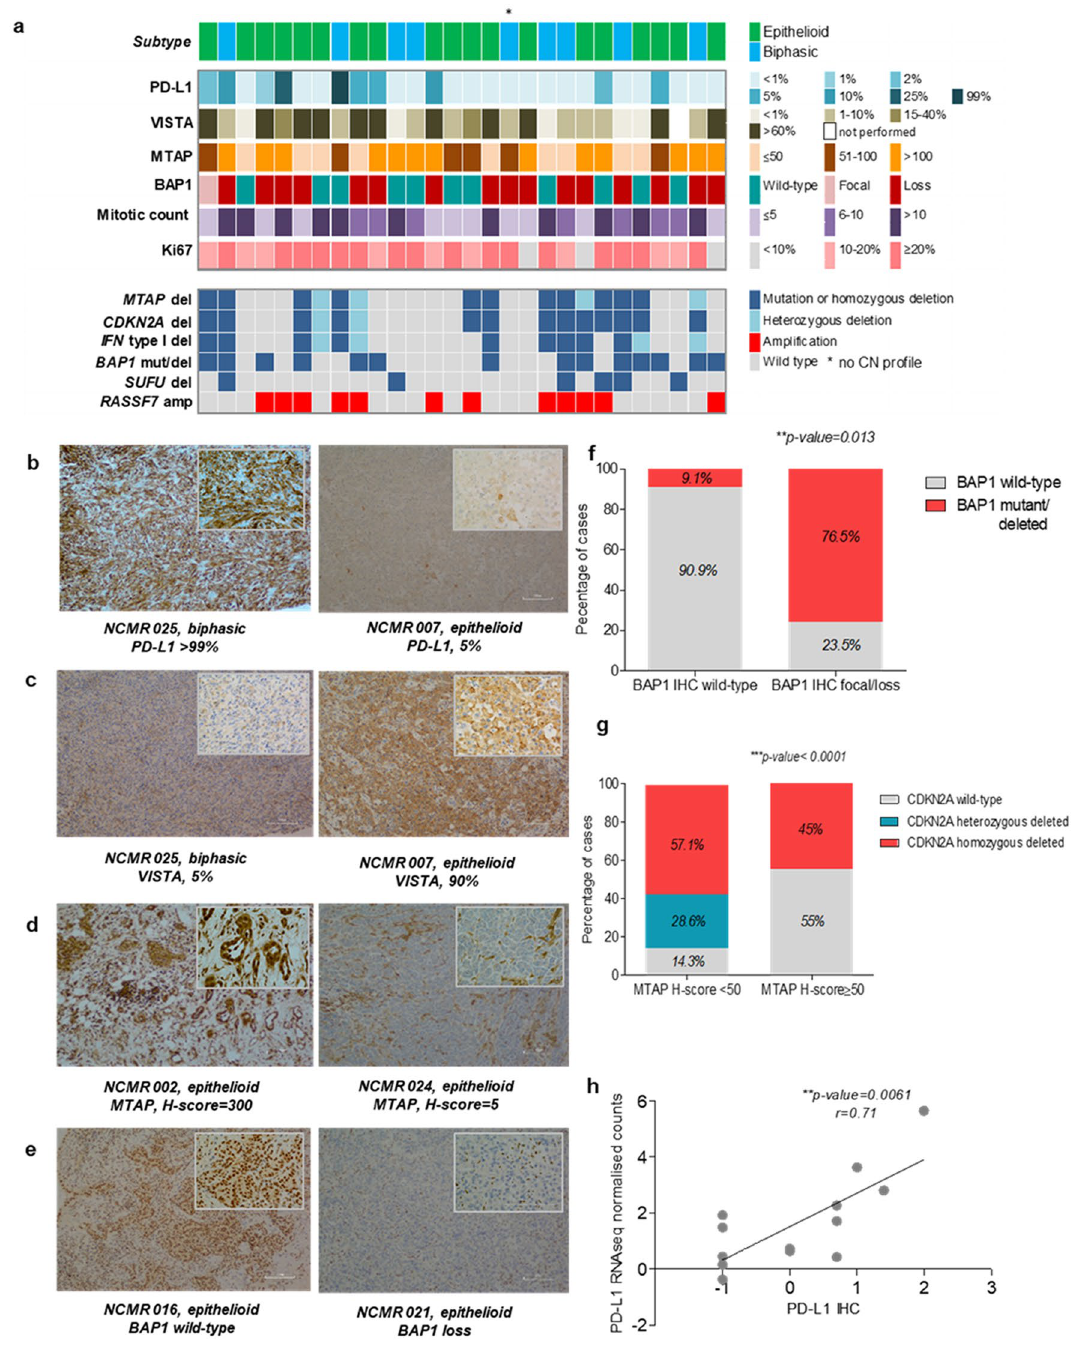
Figure 3. Histologic features of pleural mesothelioma. ( a ) Oncoplot of IHC staining and common genomic alterations; three colour coded panels are shown: the upper panel represents the histological subtype of the samples, the middle panel shows antibody staining for the proteins denoted on the left hand side of the panel (antibody staining were assessed as percentages, with the exception of BAP1; representation in the figure was done by grouping samples based on different percentage ranges that are shown in the legend on the right hand side of the panel) and the bottom panel shows any genomic alteration (mutation or copy number alteration) in the analysed samples; ( b - e ) Representative IHC images for PD-L1, MTAP and BAP1 (100 ×); ( f ) Analysis on BAP1 genomic and proteomic status by Fishers` exact test; ( g ) Analysis of MTAP H-score in CDKN2A/ MTAP deleted vs CDKN2A/MTAP wild-type by Fisher`s exact test, with a threshold for MTAP H-score set at 50; ( h ) Spearman correlation between PD-L1 gene expression and